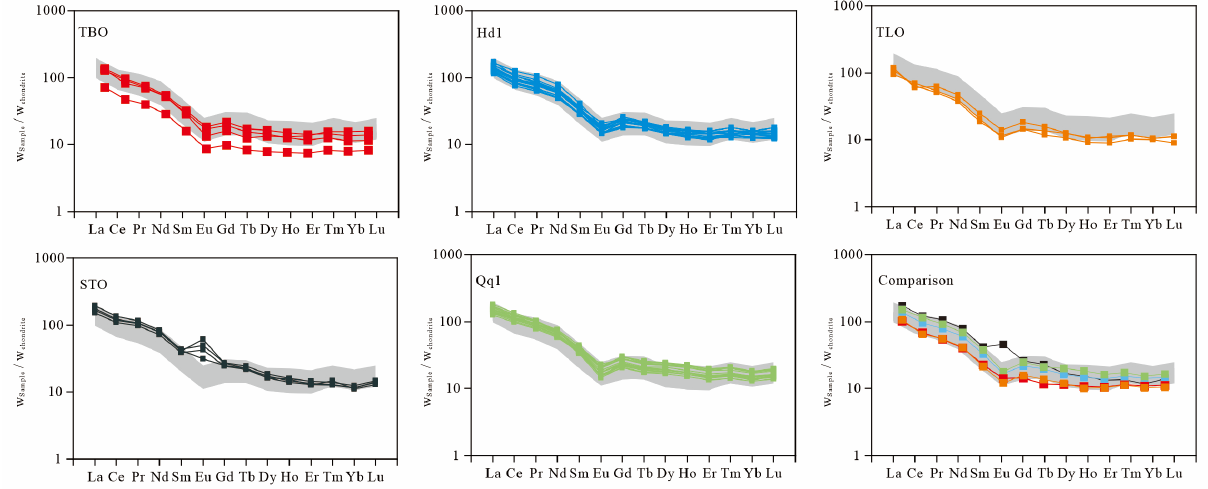
Figure 9. REE normalised spider diagram of Longmaxi-1 black shales in different provenances. Notes: TBO—Tianba Outcrop; HD1—Well of Huadi 1; TLO—Tianlin Outcrop; STO—Sutian Out- crop; QQ1—Well of Qianqian 1; the shaded area represents normalised spider diagram of REEs in Longmaxi-1 black shales of well WY1 .